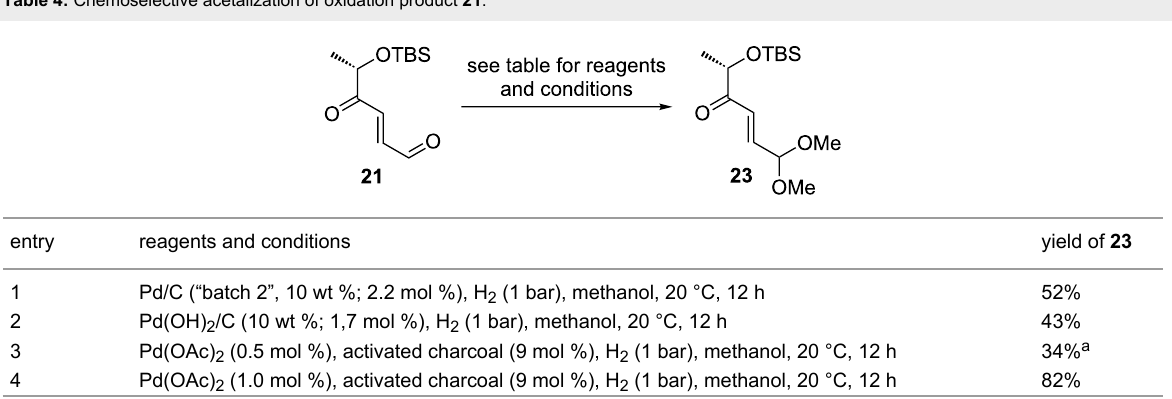
Table 4: Chemoselective acetalization of oxidation product 21